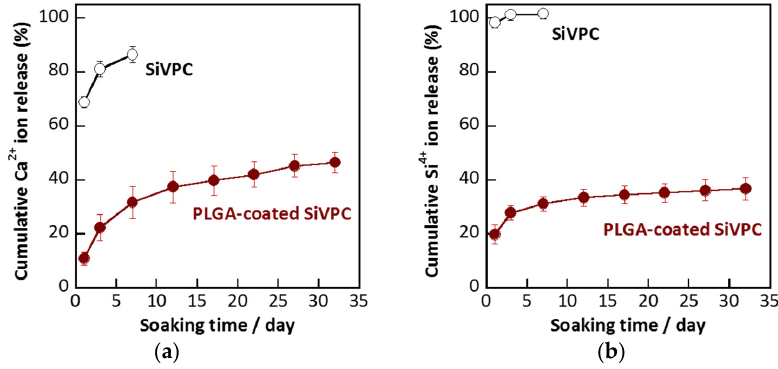
Figure 5. Cumulative ion amounts dissolved from cotton ‐ wool ‐ like materials as a function of the soaking time: ( a ) Ca 2+ ion; ( b ) silicate ion (here, measured as Si 4+ ion). The error bar shows the standard deviation ( n = 3).